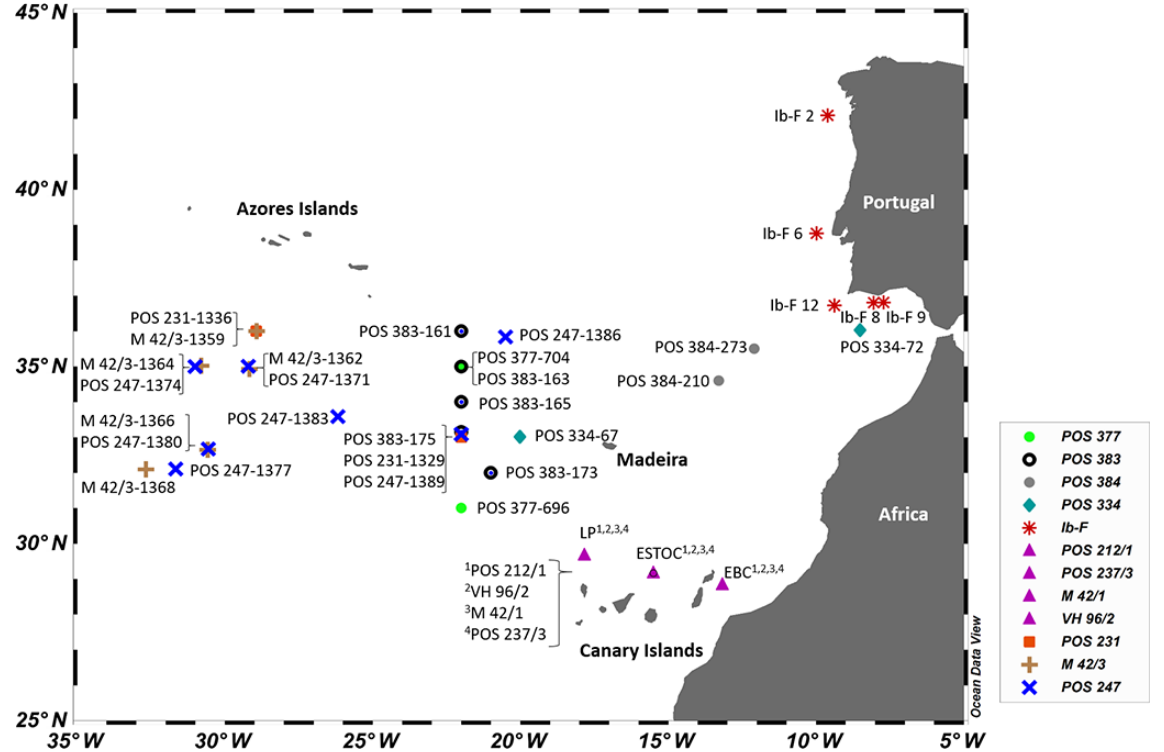
Figure 1. Plankton net stations in the eastern North Atlantic with vertically resolved planktonic foraminifera assemblage counts that were used in this study. The stations are coded by cruises. Superscript and brackets indicate repeated sampling at the same positions (for details see Table 1). Map made with ODV (Schlitzer,